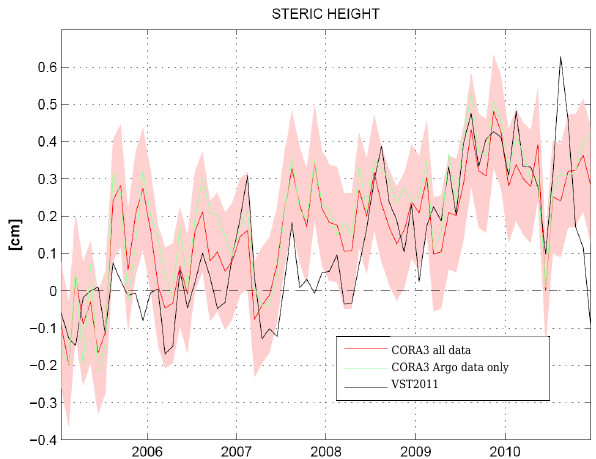
Fig. 13. Estimation of GSSL for the year 2005–2010 with a 1500m reference depth. The calculation is based on a simple box aver- aging method described in von Scuckmann and Le Traon (2011) (VST2011). Results obtained with CORA3 (red and green curves) are compared to those obtained by VST2011. The 6-yr trends ob- tained are 0 . 64 ± 0 . 12mmyr − 1 with CORA3 (0 . 58 ± 0 . 10mmyr − 1 for CORA3 with only Argo data) and 0 . 69 ± 0 . 14mmyr − 1 for VST2011. Error bars (red areas) are shown for CORA3 (all data) and are calculated as described in VST2011.This total error includes the uncertainties on the averaged parameter in every 5 ◦ × 10 ◦ × 3- month box and the choice of the reference climatology, but it does not take into account possible unknown systematic measurement